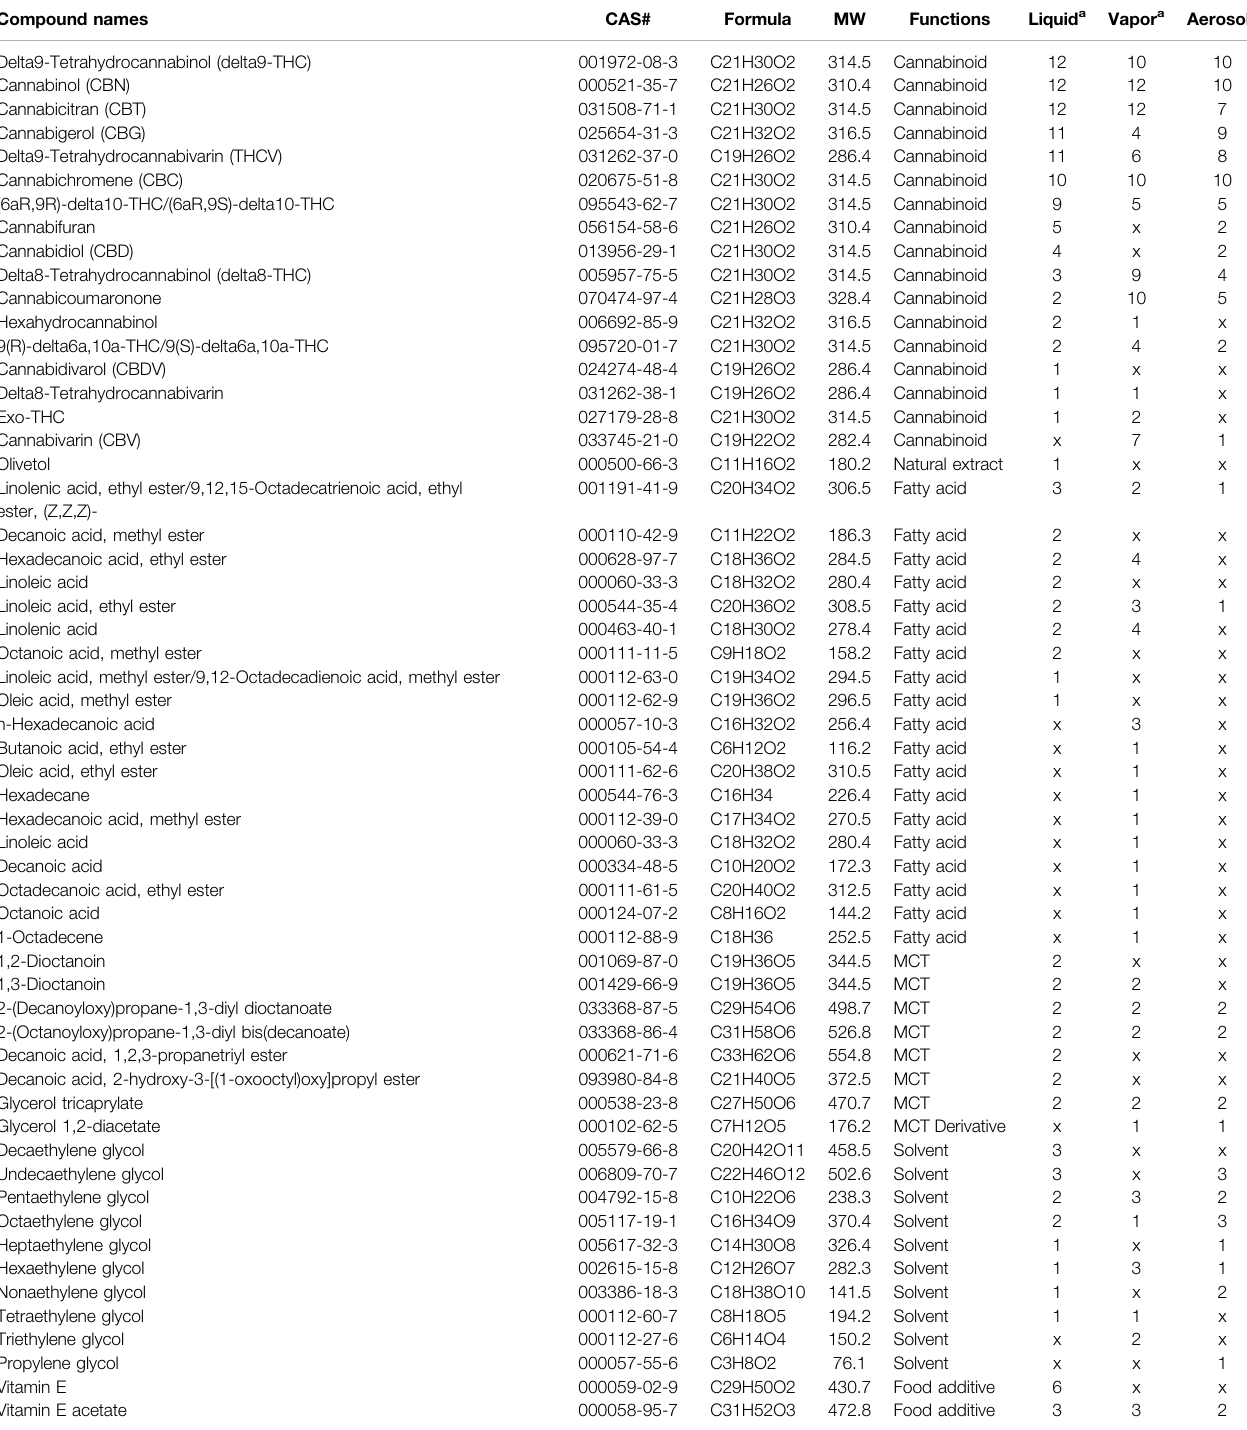
TABLE 3 | Cannabinoids and other constituents detected in vape liquid, vapor and aerosol